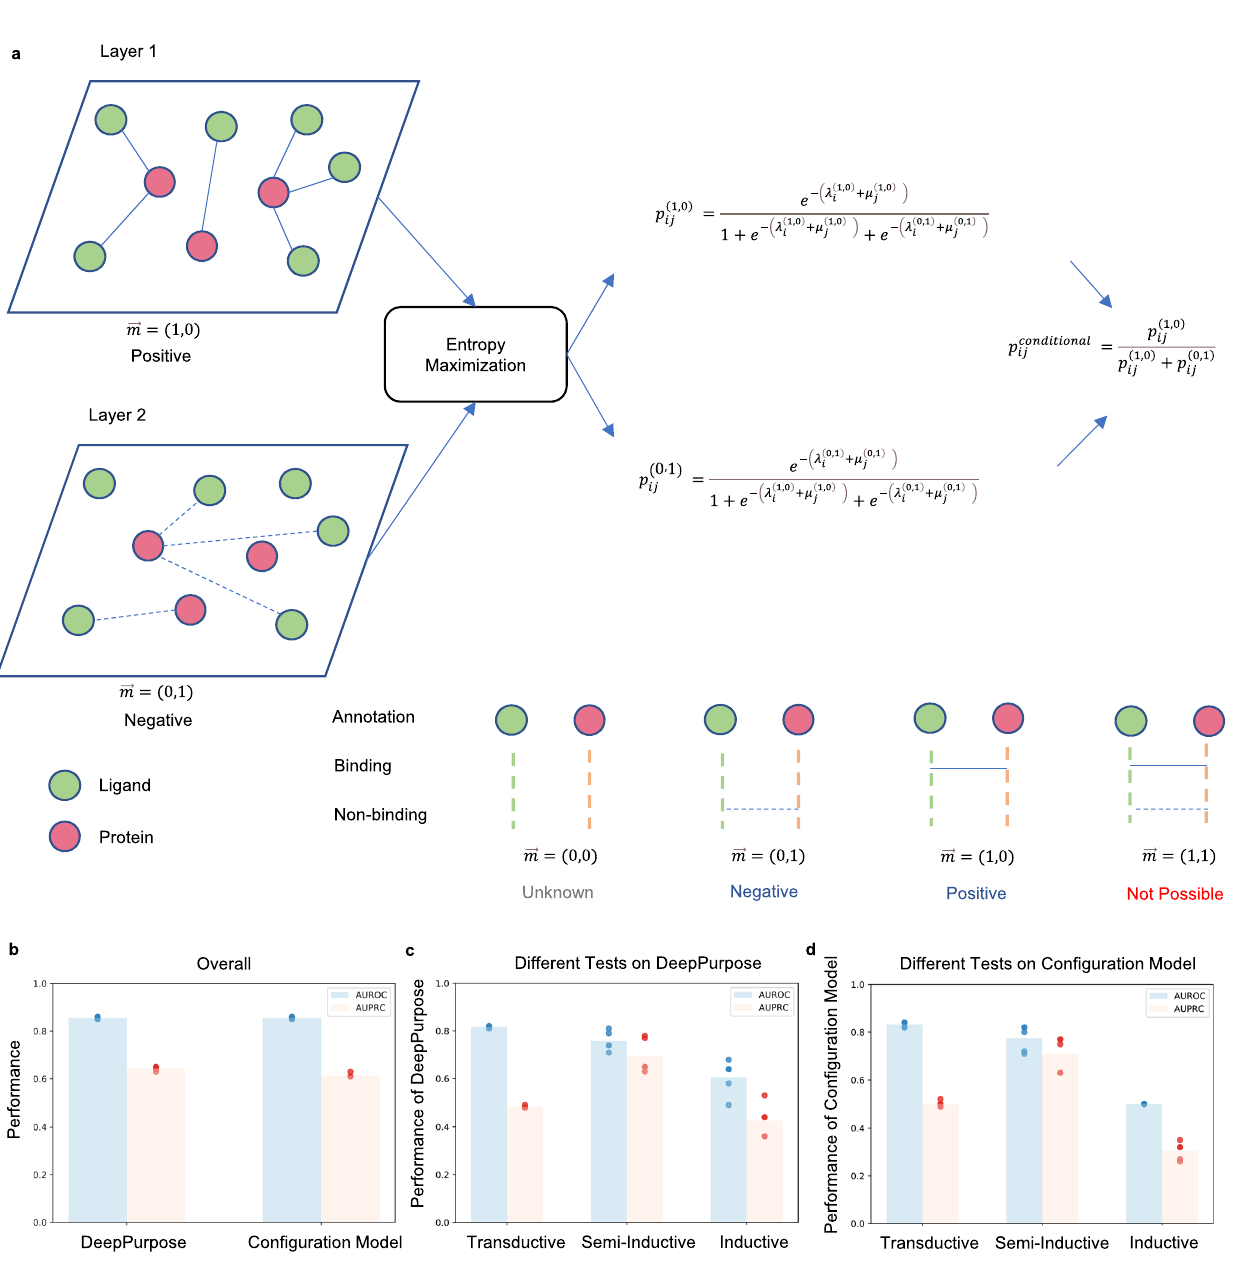
con fi guration model achieves similar results as DeepPurpose on the benchmark BindingDBdataina5-foldcross-validation(dotsrepresenttheperformanceofeach fold, bar height corresponds to the mean, n =5). Breakdown of performances shows good predictive performance in transductive and semi-inductive scenarios. However, the same models have poor predictive performance in the inductive setting. Source data are provided as a Source Data fi le.